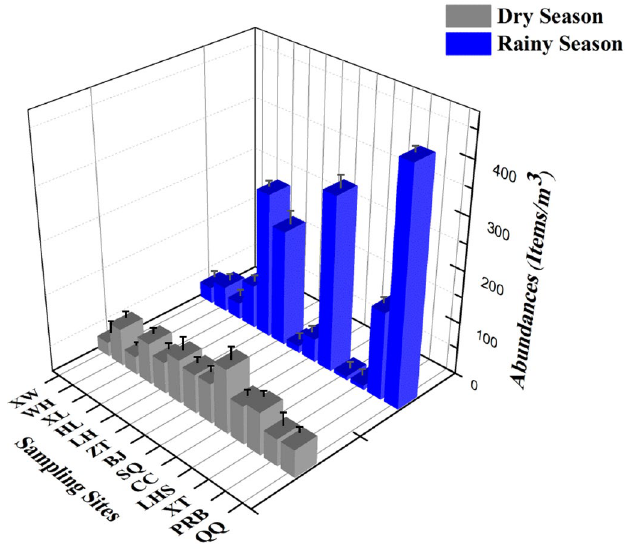
Figure 3. The microplastic abundances during different seasons in the Pearl River Delta. Note: QQ, Qingqi; PRB, Pearl River Bridge; XT, Xiaotang; LHS, Lianhuashan; CC, Chencun; SQ, Shiqiao; BJ, Beijiao; ZT, Zuotan; LH, Lanhe; HL, Hengli; XL, Xiaolan; WH, Waihai; XW, Xinwei.